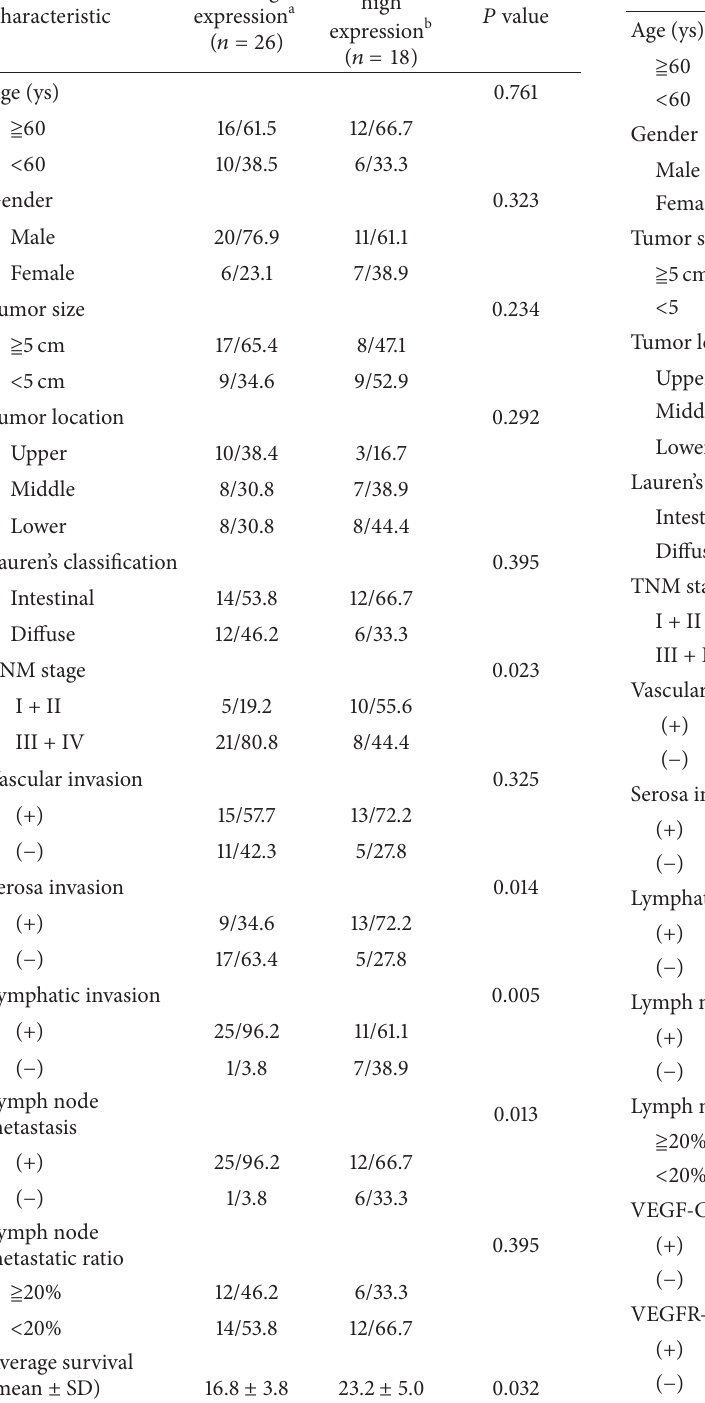
Table 5: Relationship between LVD and other clinicopathological